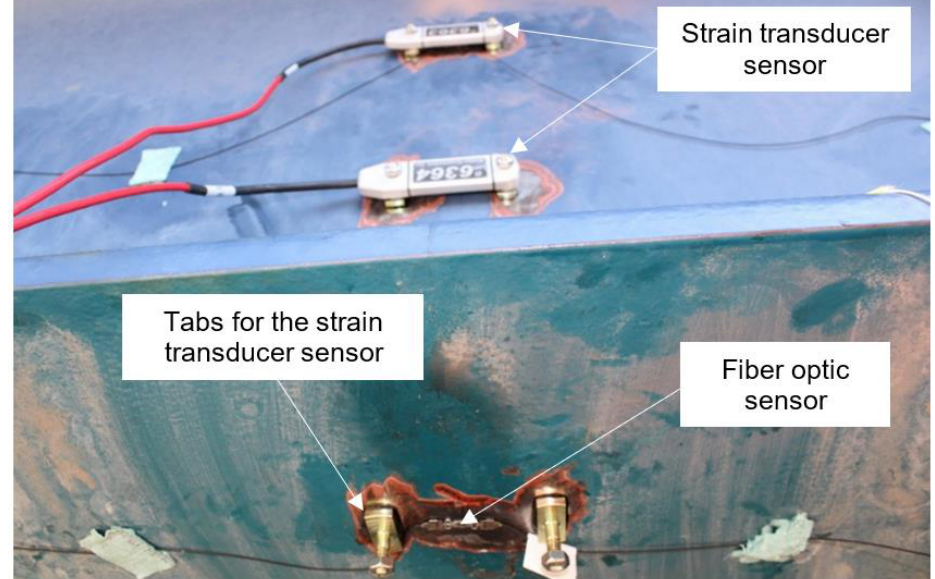
Figure 5. Location of the fiber optic and strain transducer sensors on a girder.